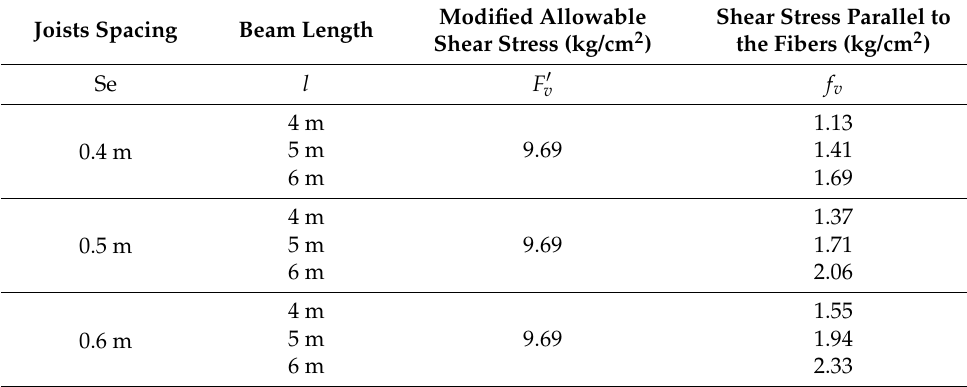
Table 9. Shear stresses values.